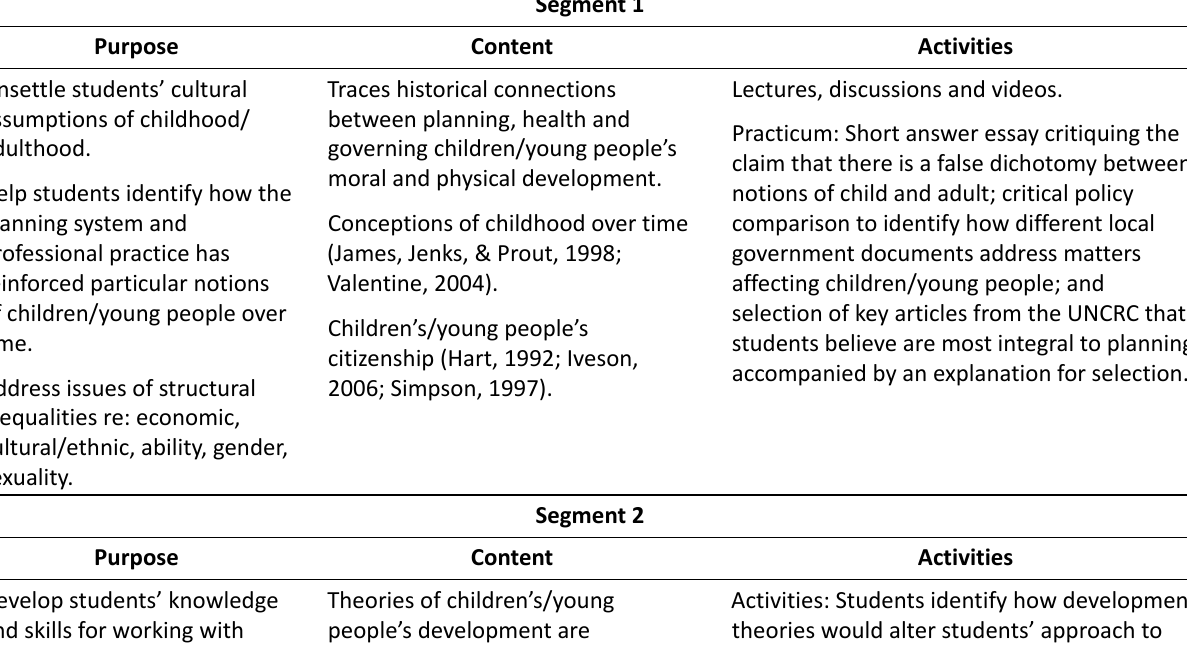
Table 1. DCE subject